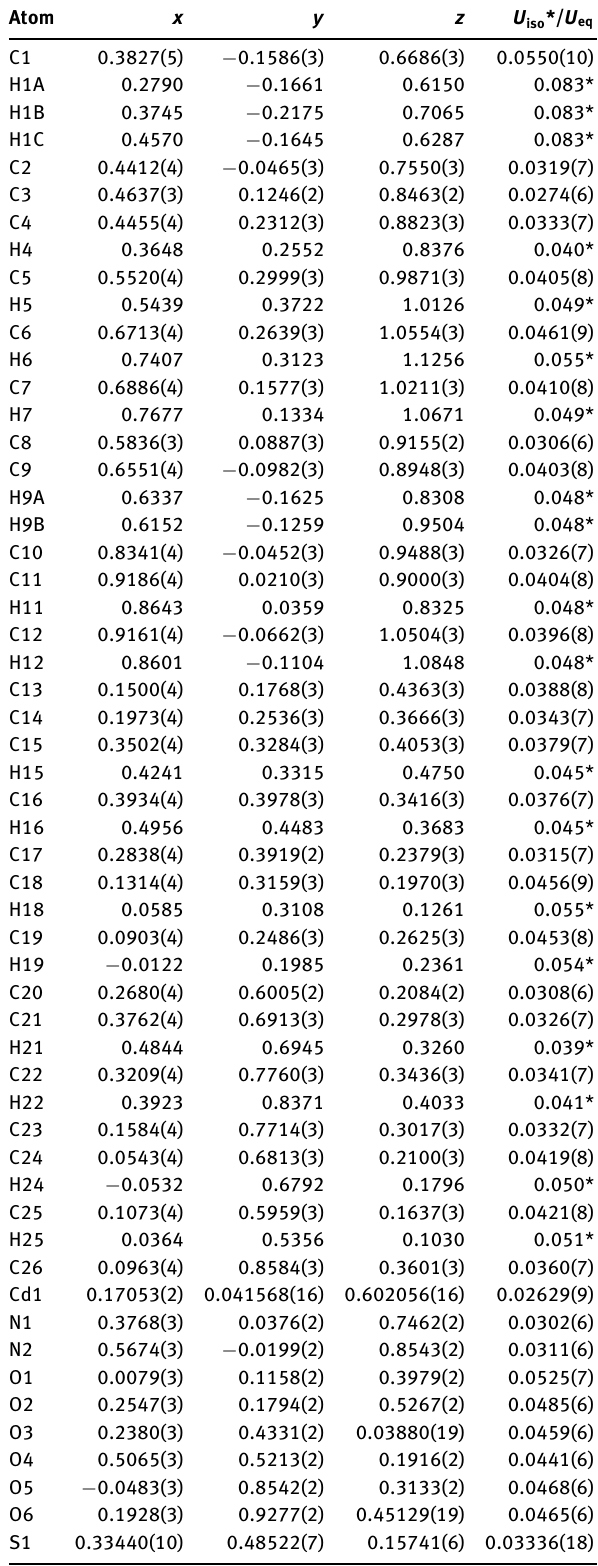
Table 2: Fractional atomic coordinates and isotropic or equivalent isotropic displacement parameters (Å 2